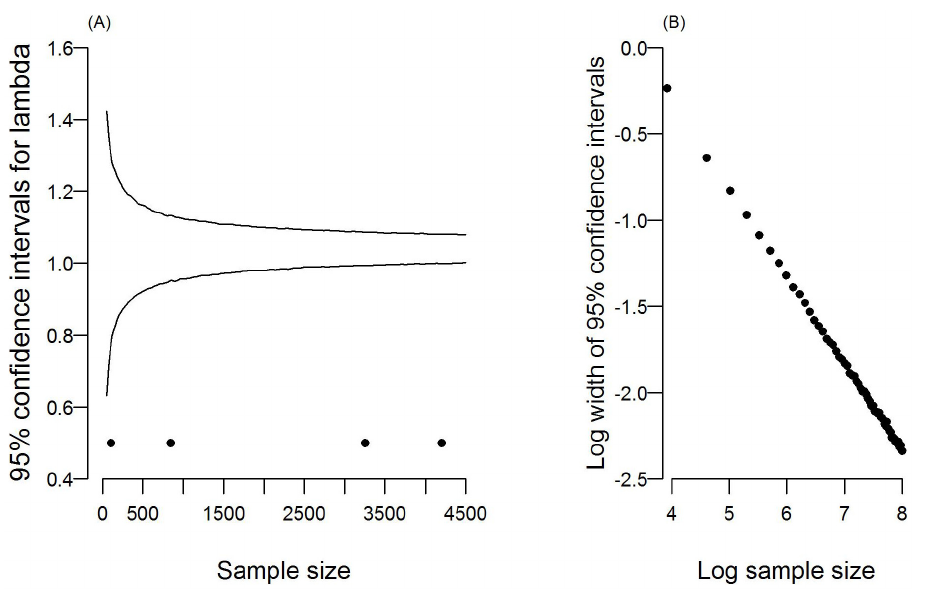
Figure 3. Effect of sample size on uncertainty associated with estimated asymptotic population growth ( l ). (a) 95% confidence intervals were calculated by resampling with replacement from the individuals available from the generic population (see text for further details). Letters indicate total sample sizes for the age distributions of the focal populations [A(N), non-hunted Australia=101; A, Australia=848; U, USA=3255; G, Generic=4204]. (b) Log sample size plotted against log of the width of the 95% confidence intervals (slope= 2 0.50).